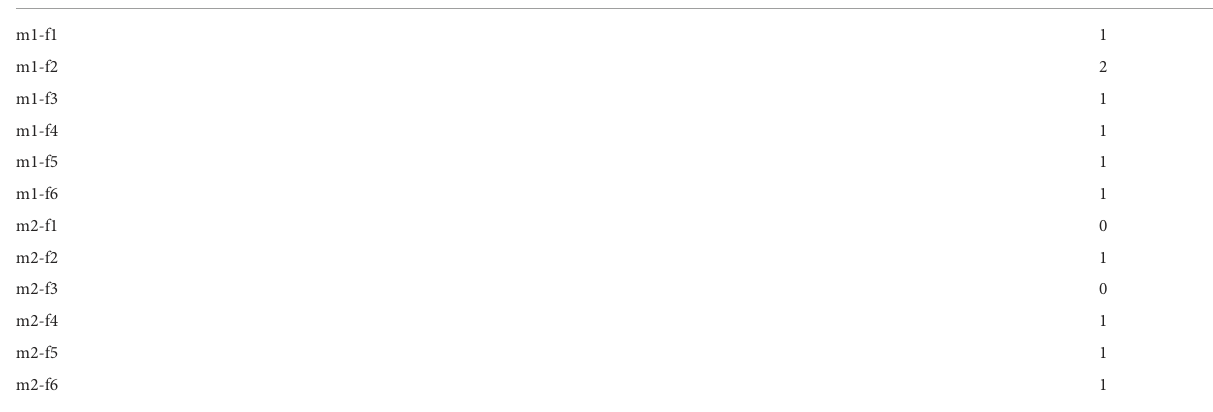
Table A3 Scores for mutual interest in a second date: 2 = both like to meet again, 1: one interlocutor likes to meet again, but not the other, 0: none is interested in a further meeting. Dating